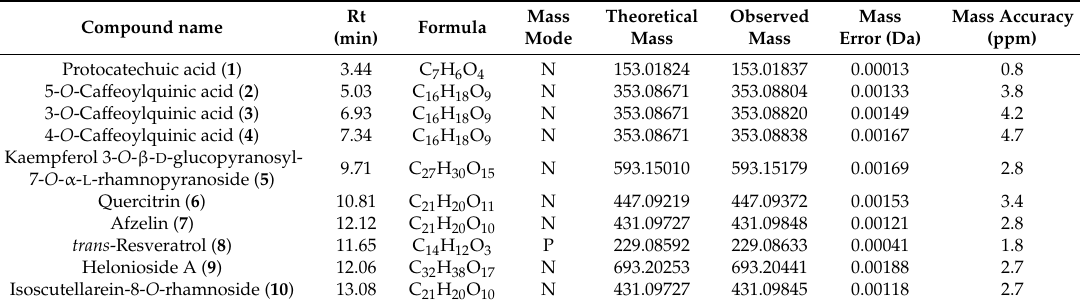
Table 5. Identification of 10 compounds in SCS via UHPLC-ESI/LTQ-Orbitrap-HRMS